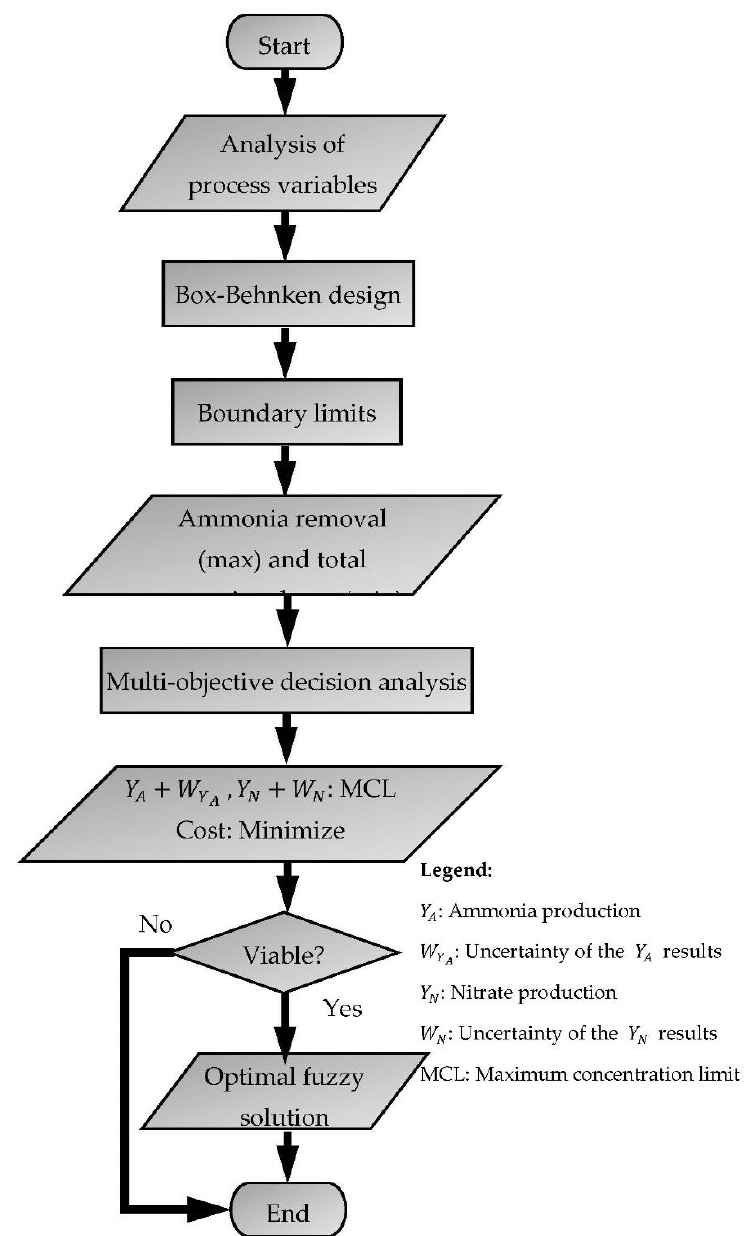
Figure 2. Multi-objective fuzzy optimization process flowchart.